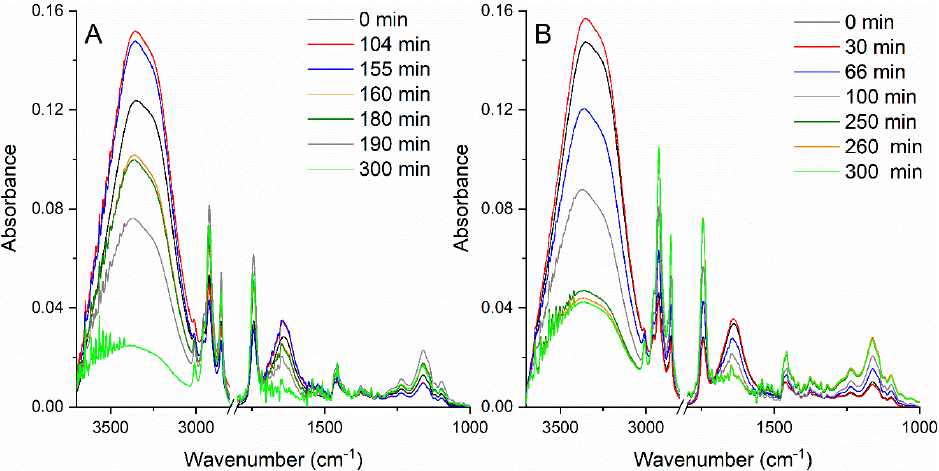
Figure 4. FTIR–ATR spectra of the unirradiated emulsion ( A ) and 1 h irradiated emulsion ( B ) recorded during 300 min.